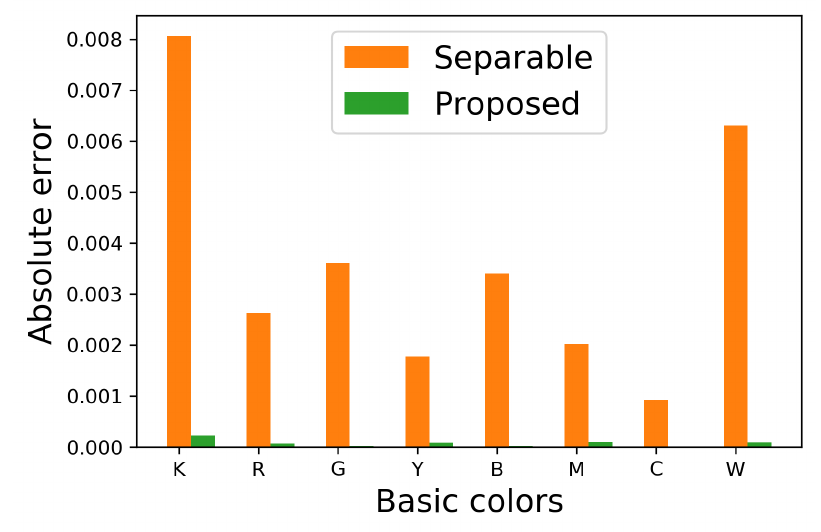
Figure 9. Absolute errors in occurrence probabilities in Figure